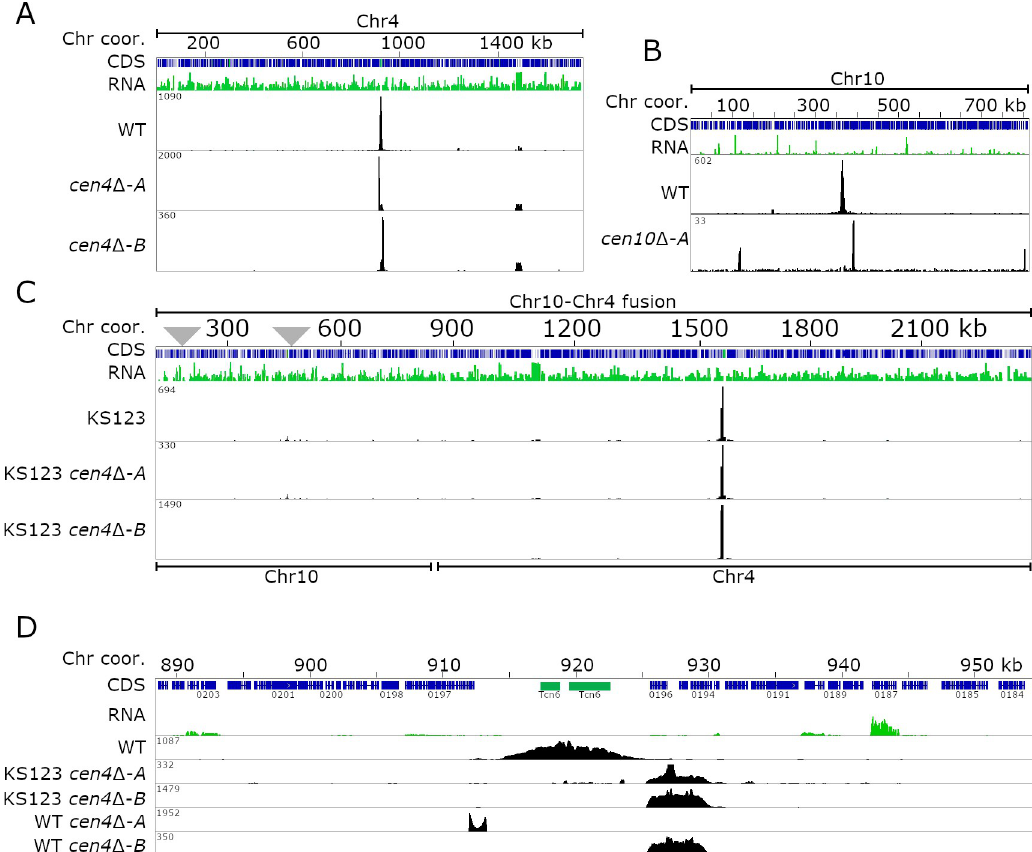
Fig 3. Neocentromeres in C . deuterogattii lack epigenetic memory. For each panel, the chromosome is indicated on top of the panel, followed by the chromosome coordinates. The genes (CDS) are shown in blue and the RNA-seq is shown in green. The CENP-A tracks are shown in black. (A) Full-length chromosomal view for Chr4, showing the position of CEN4 and the two neocentromeric strains obtained in the wild-type karyotype. (B) The panel shows the previously obtained parental dineocentromeric cen10 Δ - A strain. (C) A full-length chromosomal view of two cen4 Δ mutants in a Chr10-Chr4 fusion derived from the cen10 Δ mutant background (KS123) is shown. As shown in panel B, the initial cen10 Δ - A mutant had two CENP-A- enriched neocentromeric regions, and these inactivated neocentromeres are indicated with gray triangles. As shown with two independent cen4 Δ deletion mutants isolated in the strain harboring the fused chromosome, the neocentromere was inactivated after chromosome fusion. (D) Detailed view of native CEN4 and neocentromeric regions. The panel with CEN4 shows that neocentromeres formed proximal to the native CEN4 , and this was independent of the presence of the inactive neocentromere. In addition to CEN4 deletion in the fused strain, two independent cen4 Δ in wild-type strains show neocentromere formation in close proximity of the native centromere, and one of these neocentromere co-localizes with neocentromeres in the fused